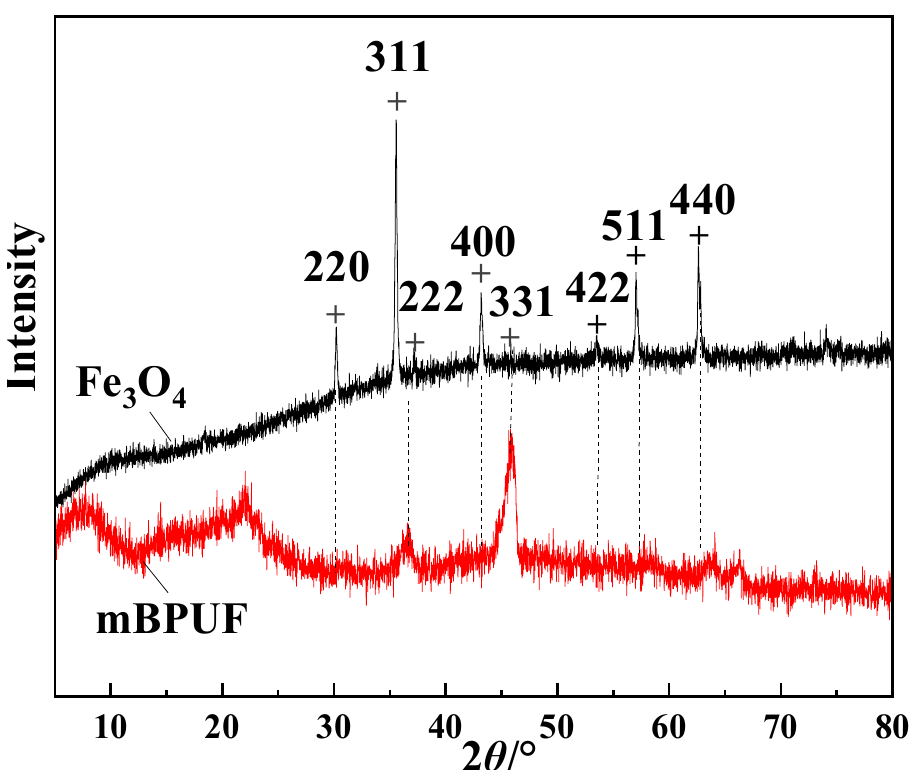
Figure 2. X-ray diffraction (XRD) spectra of the Fe 3 O 4 and the mBPUF composites. The structure of the magnetic Fe 3 O 4 , the fracture structure of the mBPUF, and its foam powders are displayed in Figure 3. Figure 3A shows that the magnetic Fe 3 O 4 structures are octahedral granular nanoparticles [22]. A porous structure for the mBPUF is shown in Figure 3B, which has embedded within it plenty of magnetic parti- cles. These particles are mostly evenly distributed within the foam holes, while some are scattered on the walls or retained within the interior of the pores, as shown in Figure 3D,F. The element features for the structure are exhibited in Figure 3E,G. The tagged spectrum 1 and spectrum 3 are the ones that reveal the characteristics of the magnetic Fe 3 O 4 nanoparticles. Figure 3C is an image of the foam powders, which have an irregular shape. Here, the edges of the powder are smooth after the foam is crushed.